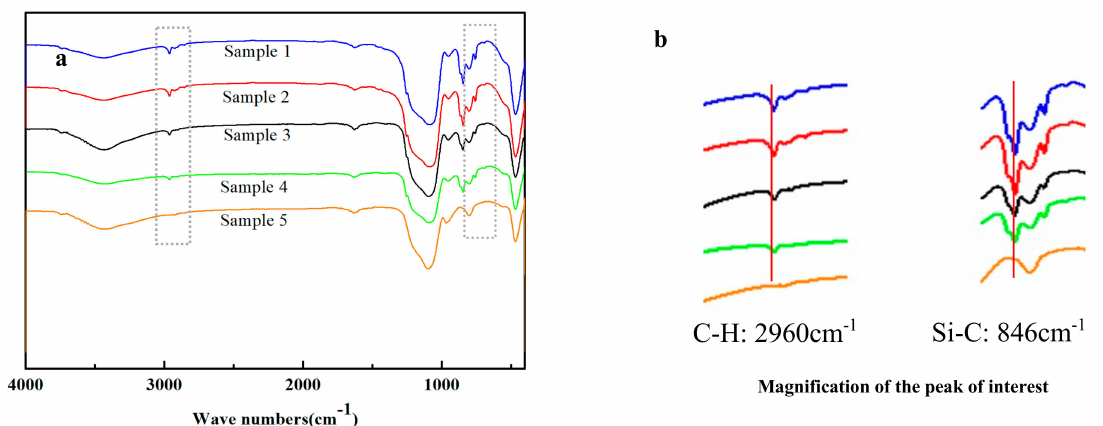
Figure 6. FT-IR spectra of silica aerogels ( a ) and the magnification of the peaks of interest ( b ).